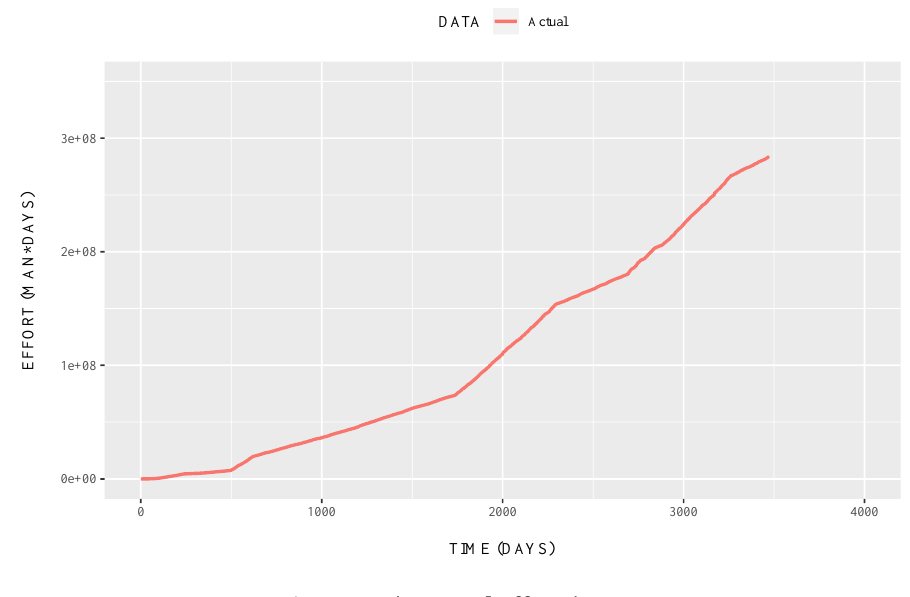
Figure 1. The actual effort data set